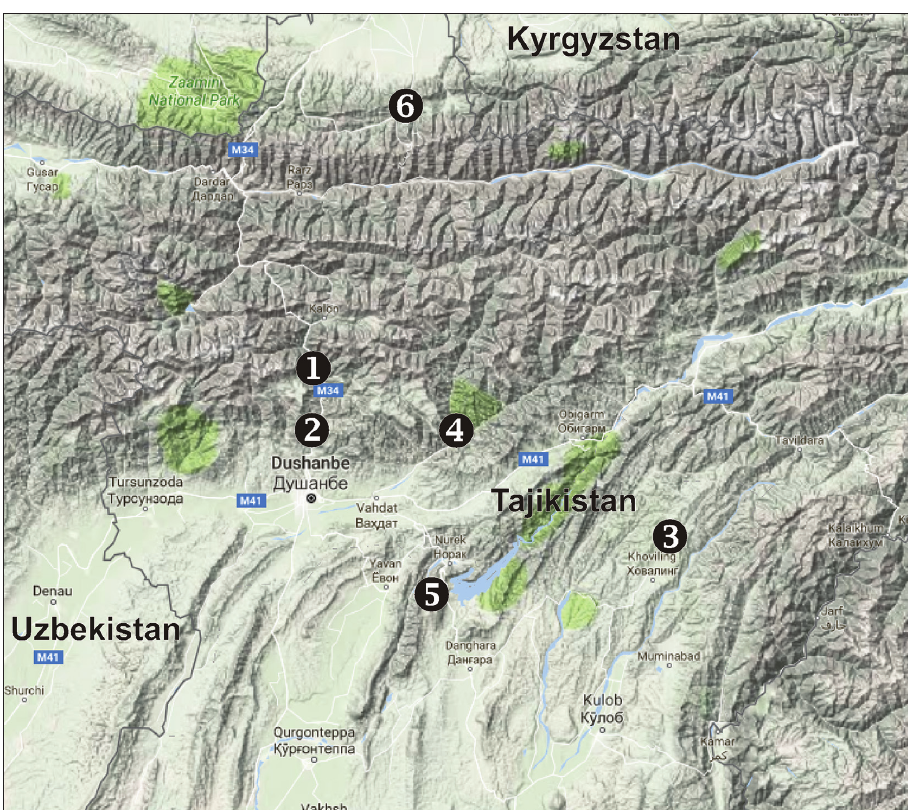
Figure 8. Localities of Pireneitega species from Tajikistan. 1 P. zonsteini sp. n. 2 P. muratovi sp. n. 3 P. tyurai sp. n. 4 P. ramitensis sp. n. 5 P. kovblyuki sp. n. 6 P. major